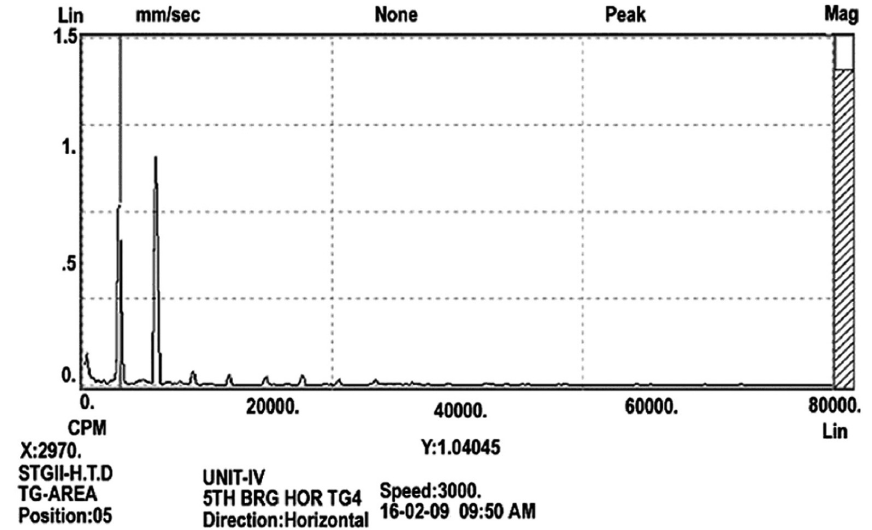
Fig. 4. Vibration spectrum that shows the maximum amplitude at power line.